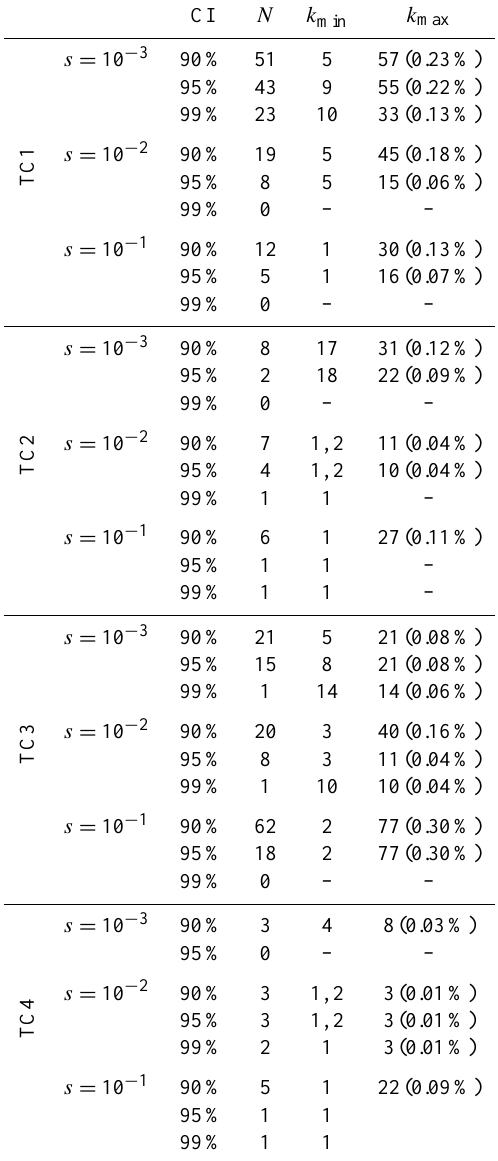
Table 2. Confidence interval test. N is number of outliers, k min and k max being rank orders of first and last outlier, respectively. Ratios between k max and sample size are in parentheses.